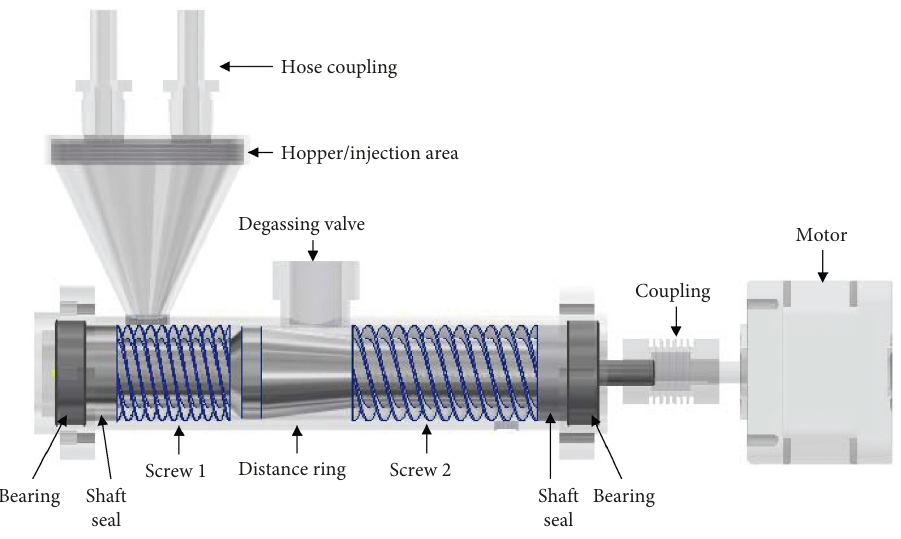
Figure 3: Final extruder prototype, screw